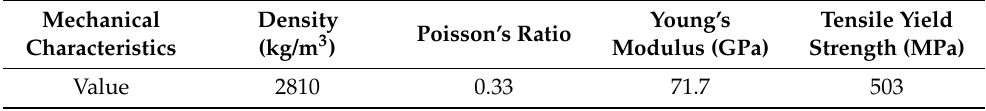
Table 1. AL7075 mechanical